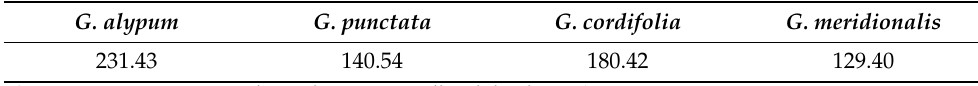
Figure 6. Effect of G. alypum ( GA ), G. punctata ( GP ), G. cordifolia ( GC ) and G. meridionalis ( GM ) methanolic leaf extracts on cell viability of: ( a ) MDA-MB-231 breast cancer cell line; ( b ) A1235 glioblastoma cell line; * statistically significant difference in comparison to control ( p < 0.05); values are means + SD ( n = 4). Table 9. Effect of G. alypum , G. punctata , G. cordifolia and G. meridionalis methanolic leaf extracts on viability of A1235 cancer cell line expressed as IC 50 values ( µ